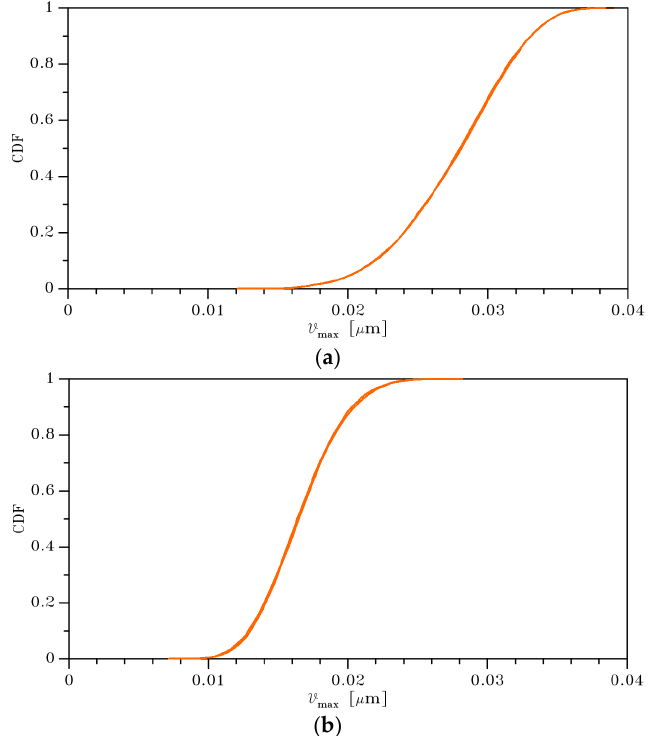
Figure 9. Monte Carlo simulation: cumulative distribution functions of V max for ( a ) h = 2 µ m and ( b ) h = 3 µ